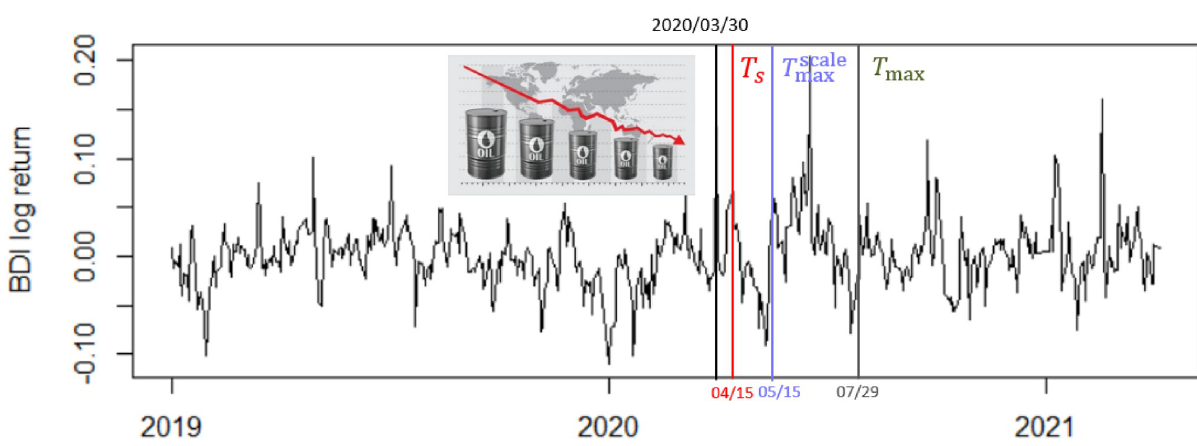
Fig 14. Change point of BDI: Brent crude oil fell